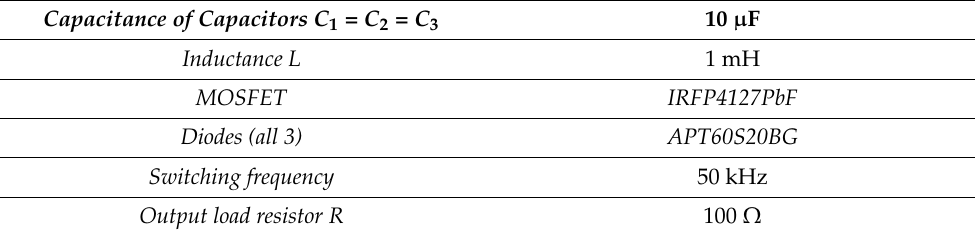
Table 4. Parameters of simulation in Figure 24a.